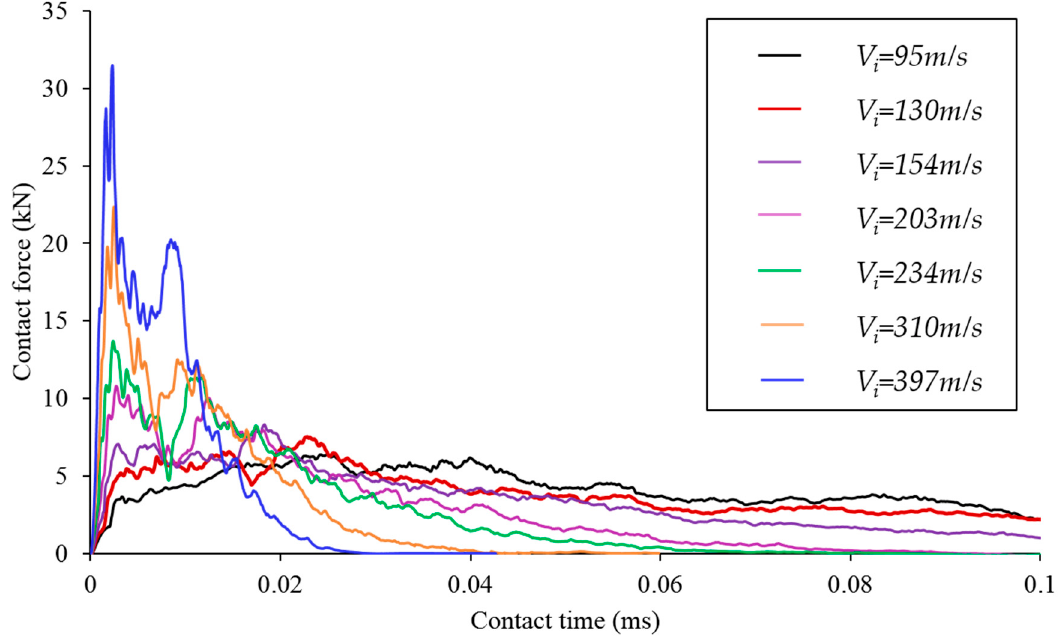
Figure 5. Contact force history of the TFML-2/1 target panel at different impact velocity.